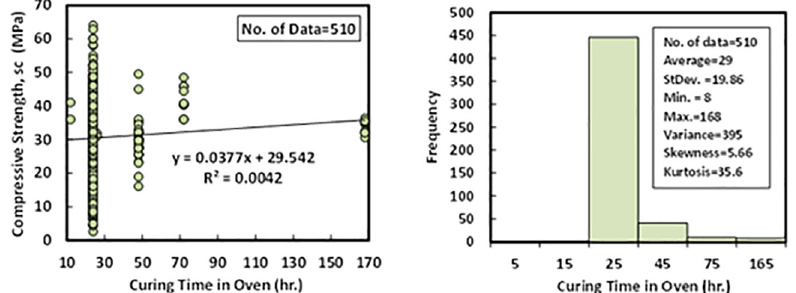
Fig 12. Variation between compressive strength and curing duration with histogram of fly ash-based geopolymer concrete mixtures.